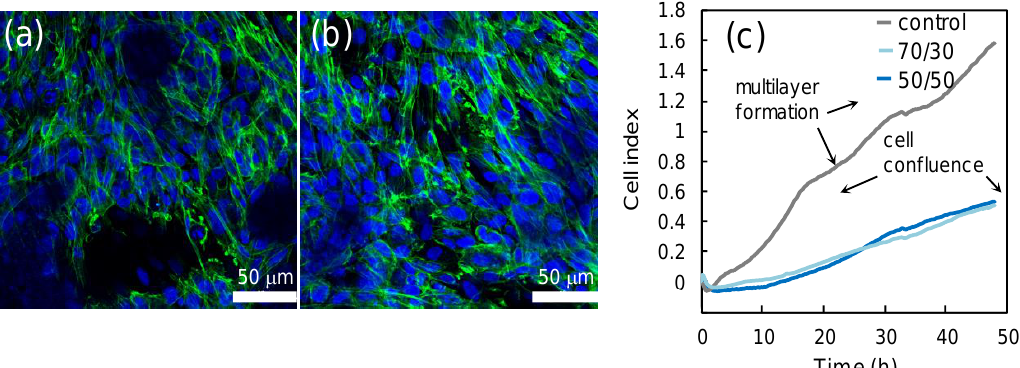
Figure5. ConfocalimagesofCHOcellsgrowingon50 / 50PCL / PFA( a )and70 / 30PCL / PFA( b ). Nucleiare labeled with DAPI (4 (cid:48) ,6-Diamidino-2-phenylindole dihydrochloride, blue) and cytoskeleton is labeled Figure 5. Confocal images of CHO cells growing on 50/50 PCL/PFA ( a ) and 70/30 PCL/PFA ( b ). 320 with Alexa-Fluor Phalloidin (green). The cells morphology is healthy. The real-time proliferation curves Nuclei are labeled with DAPI (4′,6-Diamidino-2-phenylindole dihydrochloride, blue) and 321 are displayed in panel ( c ). On PCL / PFA, cells reached confluence after 48 h. The growth rate decreased cytoskeleton is labeled with Alexa-Fluor Phalloidin (green). The cells morphology is healthy. The 322 compared to control, where cells built multilayers (see Figure S2), as the multistep curve real-time proliferation curves are displayed in panel ( c ). On PCL/PFA, cells reached confluence after 323 48 h. The growth rate decreased compared to control, where cells built multilayers (see Figure S2), as 324 the multistep curve indicates. 325